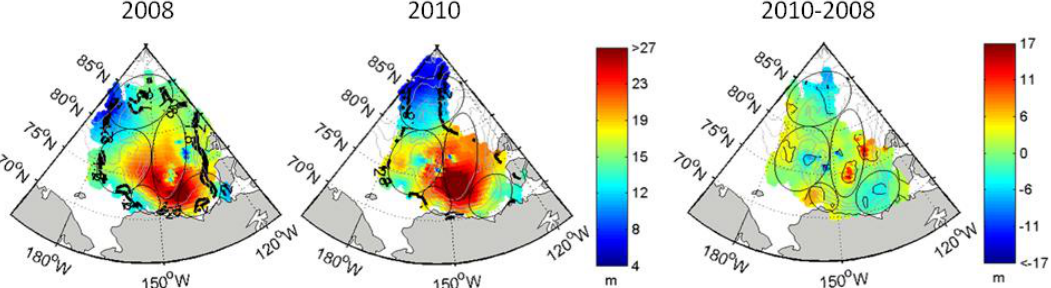
Figure 10: Kriging interpolation of H FW , the liquid freshwater content, for years 2008 (left panel) and 2010 (middle panel), and the evolution between the two years (right panel). On the left and middle panels, thick black dashed isolines correspond to estimation error ( σ ) due to Kriging interpolation process. The isolines represented are σ = 1.8m and σ = 2m. In the right panel, thin black isolines correspond to 95% significance.